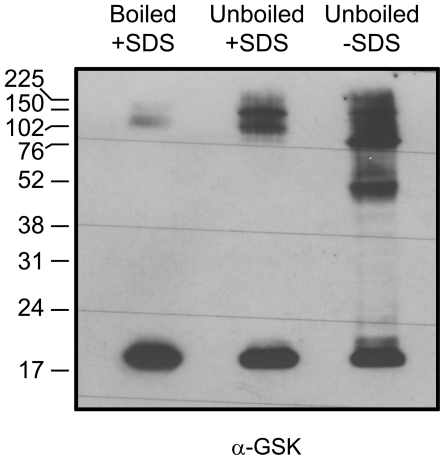
Multimeric complexes formed by VgrG in F. tularensis LVS.VgrG proteins contained in the pellet fraction of a ΔvgrG null mutant expressing VgrG-GSK in trans were separated by SDS-PAGE and identified by immunoblot using antiserum specific to GSK. Large, multimeric VgrG complexes are formed when SDS and/or sample boiling are omitted. Amersham full range rainbow molecular weight marker was used in this analysis and the sizes in kDa are indicated. The experiment was repeated at least two times and a representative example is shown.